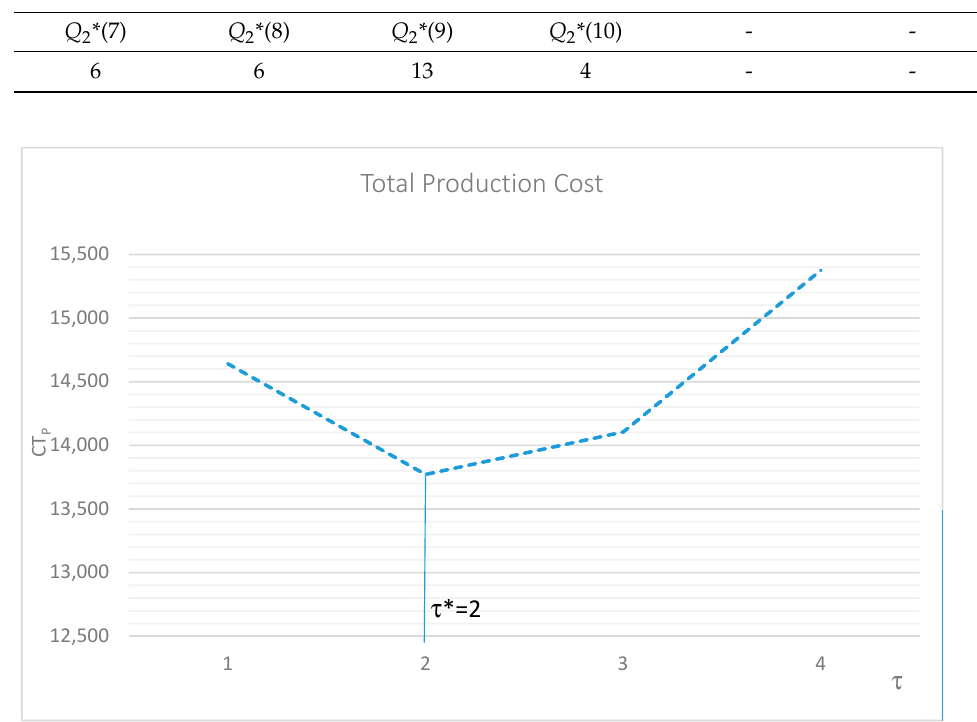
Figure 6. Total production cost as a function of delivery delay, τ . Example 2 (increased average of demand):